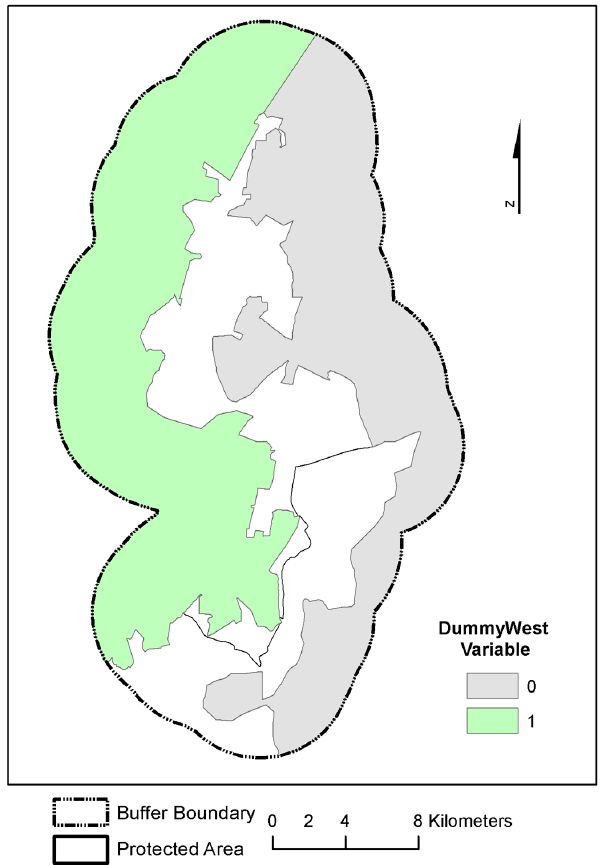
Figure 3. Map showing DummyWest variable where 1 denotes the zone west of the protected area with a higher tree plantation gain than the zone 0 representing the eastern part of the protected area.